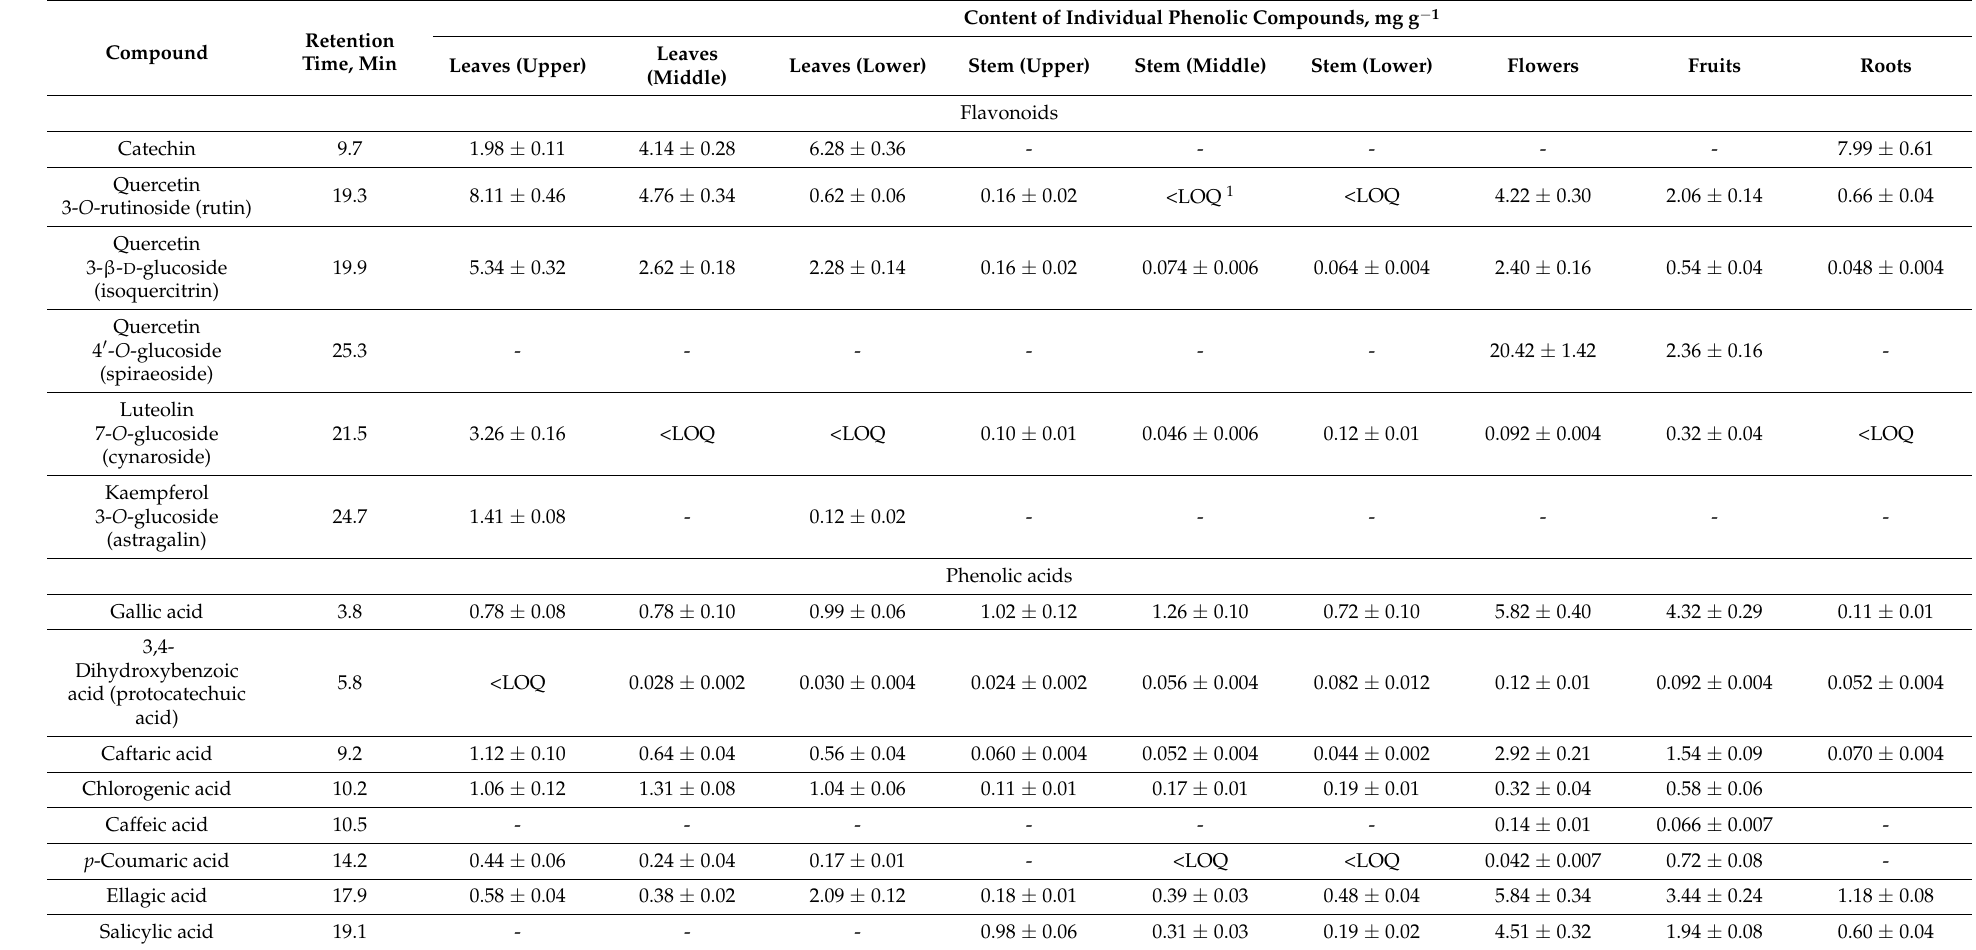
Table 2. Content of phenolic acids and flavonoids in the different parts of